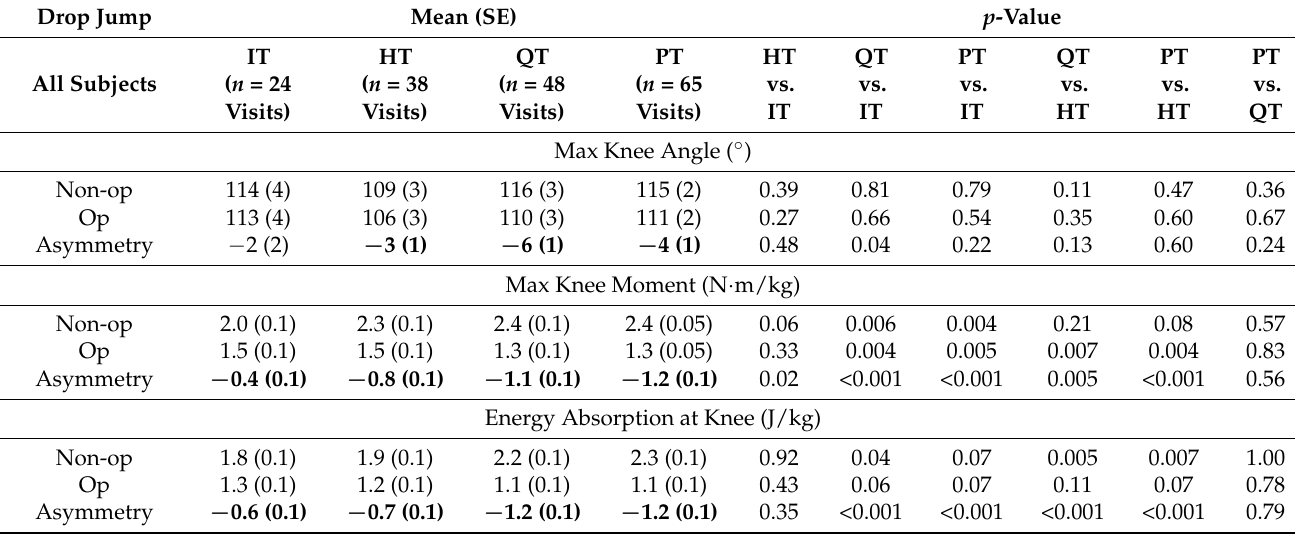
Table 2. Comparison of sagittal knee kinematics/kinetics for operative and non-operative limbs during vertical drop jump for complete sample.